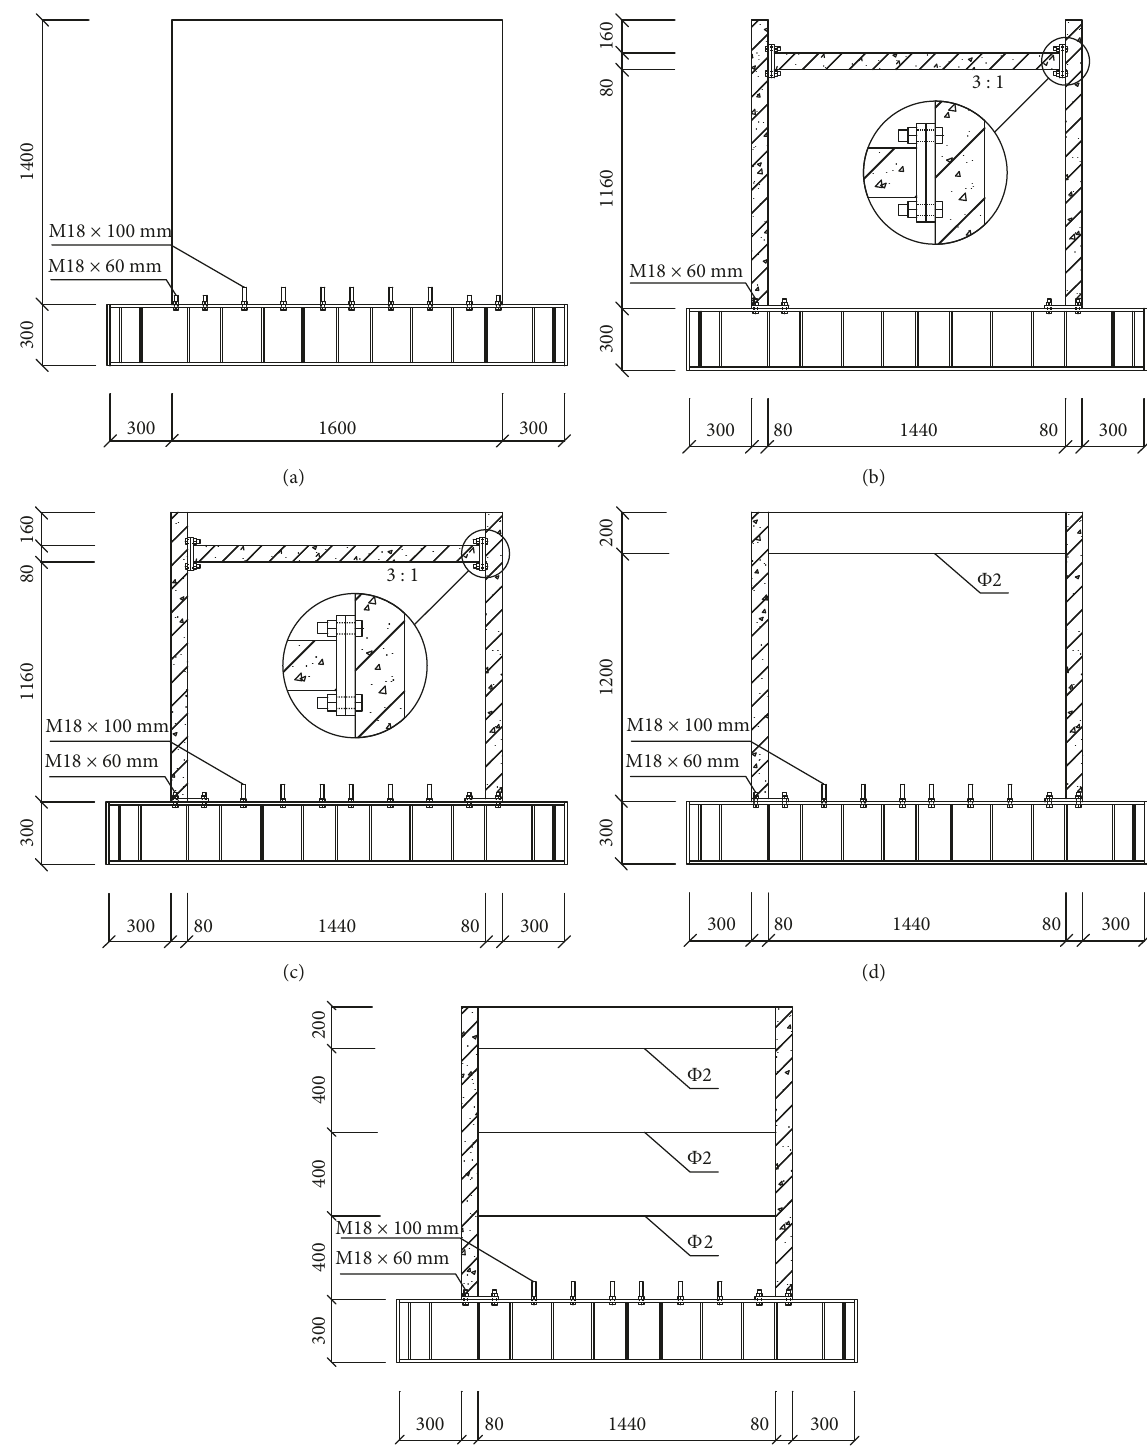
Figure 1: Dimensions and details of test specimens (unit: mm). (a) Q-1. (b) K-1. (c) Q-2. (d) Q-5. (e)